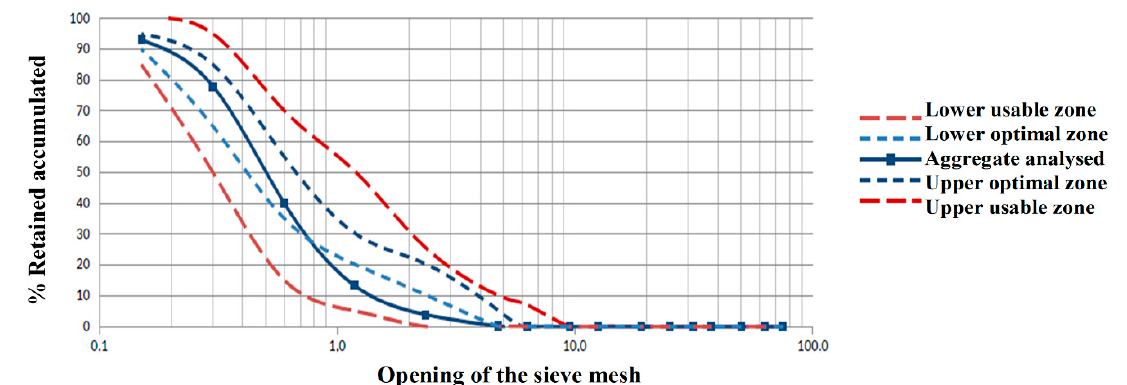
Figure 1. Granulometry curve of the fine aggregate used.